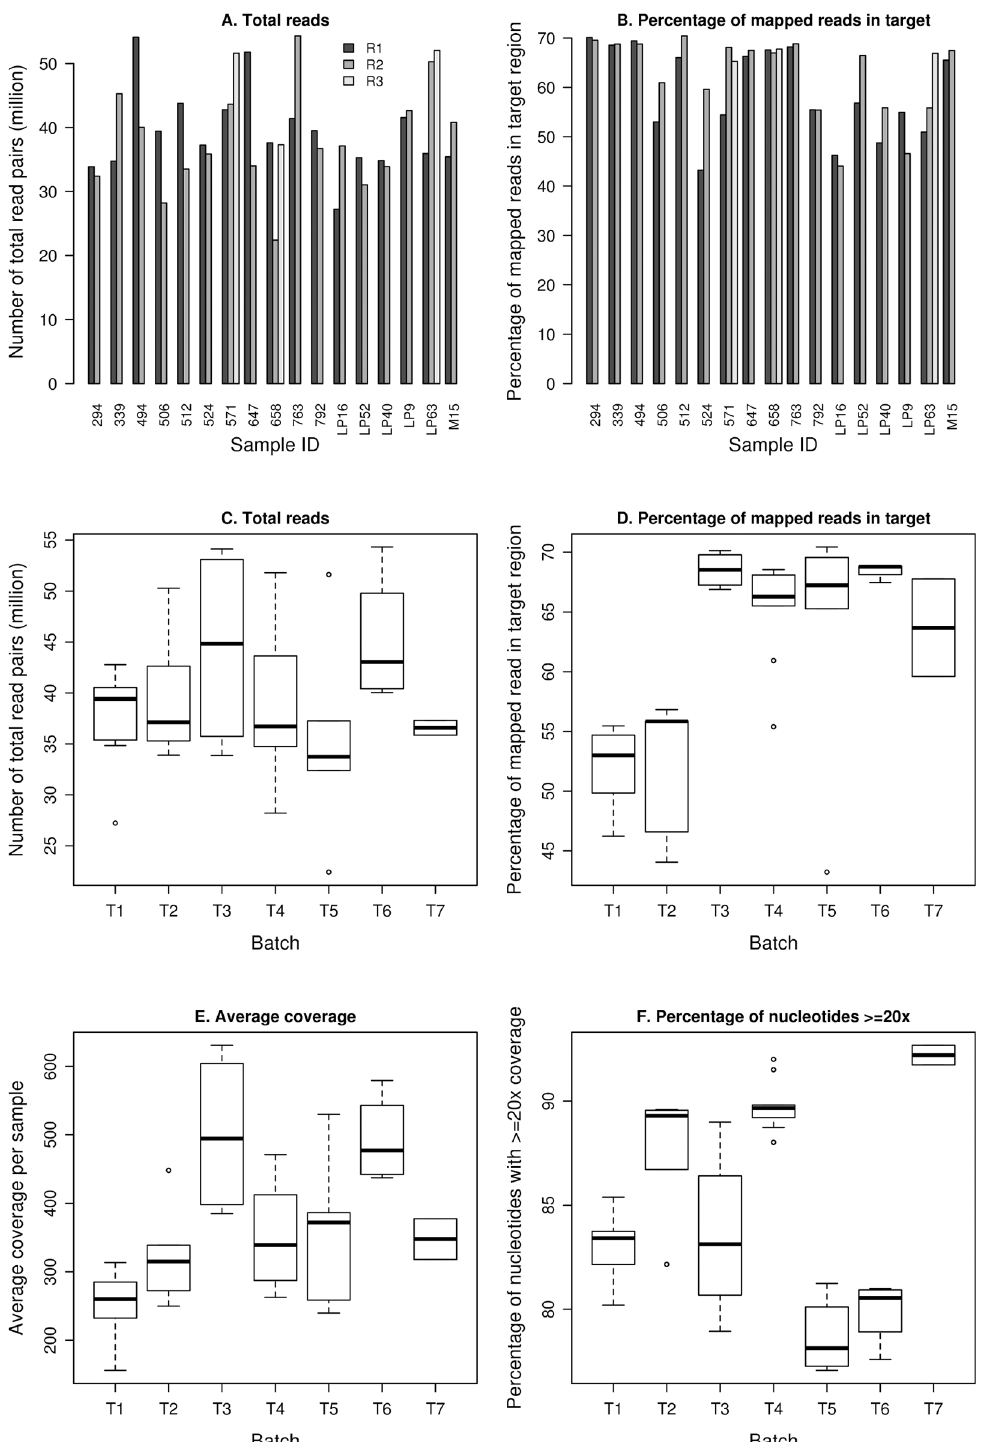
Fig 1. Barplots and boxplots showing variations in basic sequencing metrics between replicated samples and batches. Barplots of (A) the number of total reads (i.e. number of reads of F3- and F5-tagged paired reads), and (B) percentage of mapped reads in target region for each of the replicate pairs. The boxplots show the batch-to-batch differences in the number of total reads (C), the percentage of mapped reads in the target region (D), the average coverage (E), and the percentage of nucleic acids with (cid:3) 20x coverage within the target region (F).